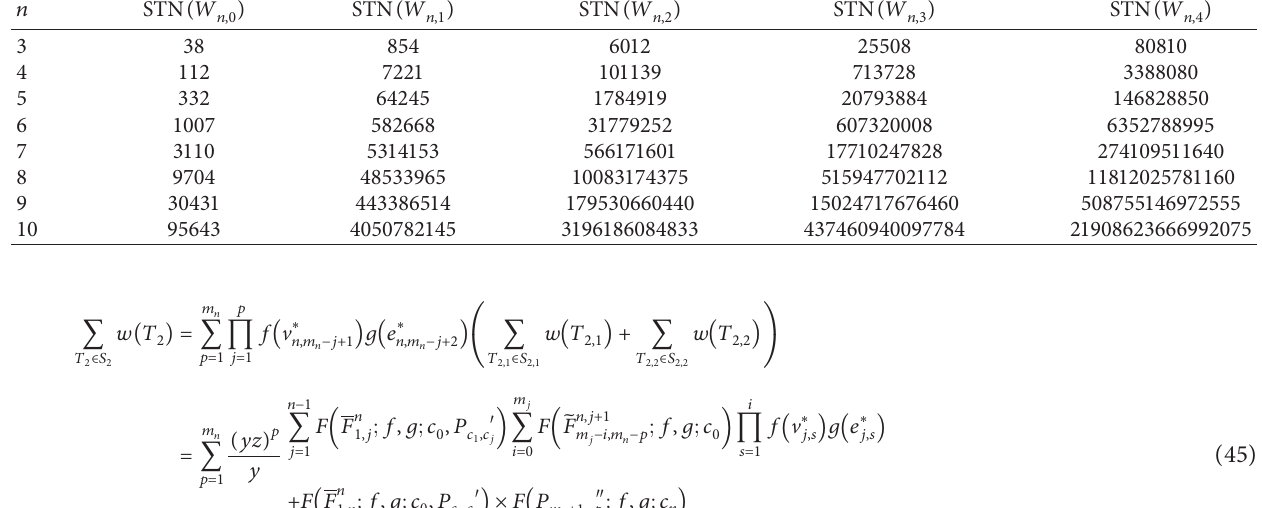
Table 3: The subtree number index STN ( W